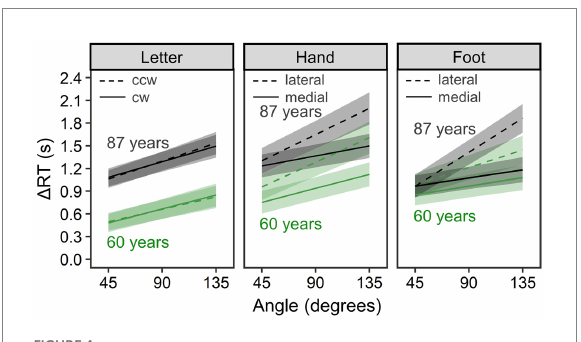
FIGURE 4 Comparison of mental rotation performance within the older group ( n = 71). Δ RT is reaction time (RT) of the mental rotation task from which the mean choice RT was subtracted. Lines and error bands represent estimated means and their 95% credible intervals, respectively. Although age was treated as a continuous variable, we substituted the minimal and maximal values of age in our older sample (i.e., 60 and 87 years old) for the estimated models for visualization.